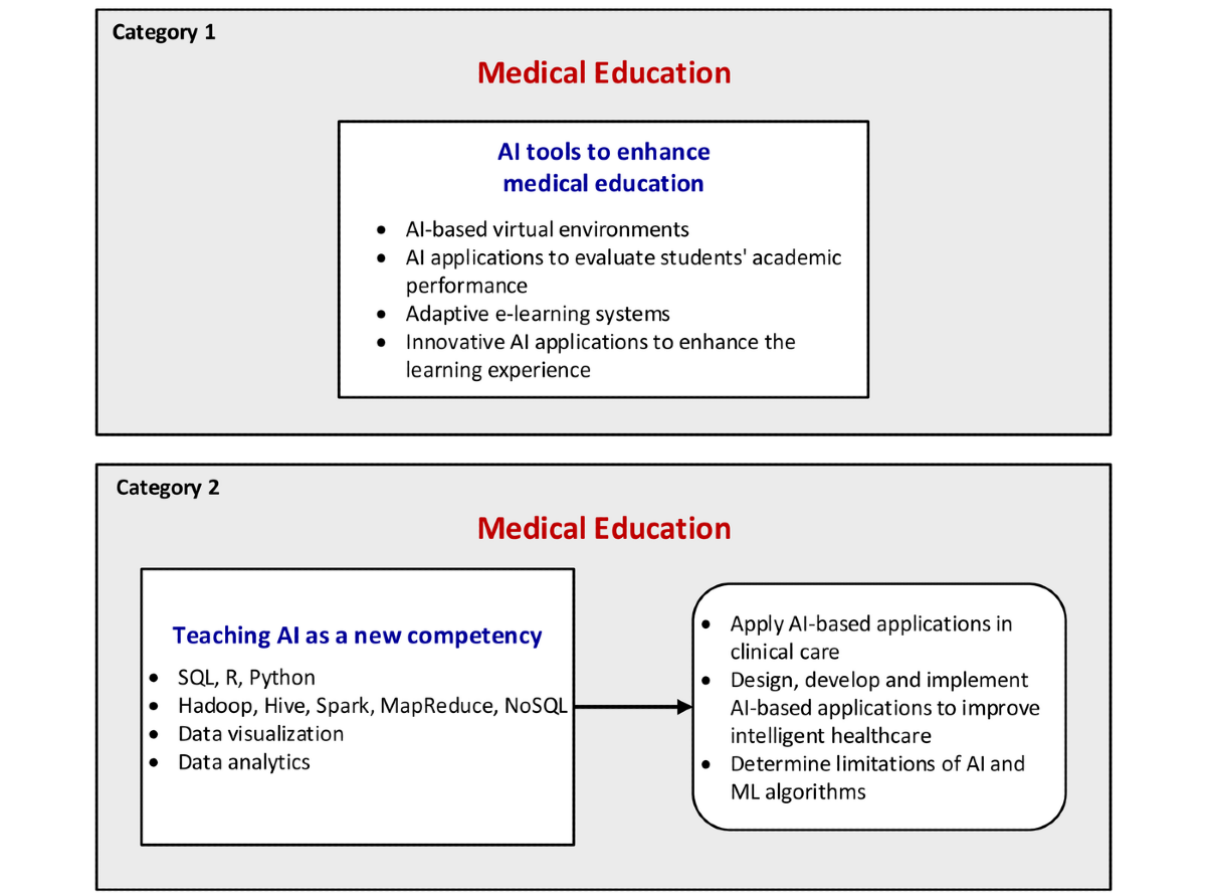
Figure 4. Classification of selected AI publications. AI: artificial intelligence; ML: machine